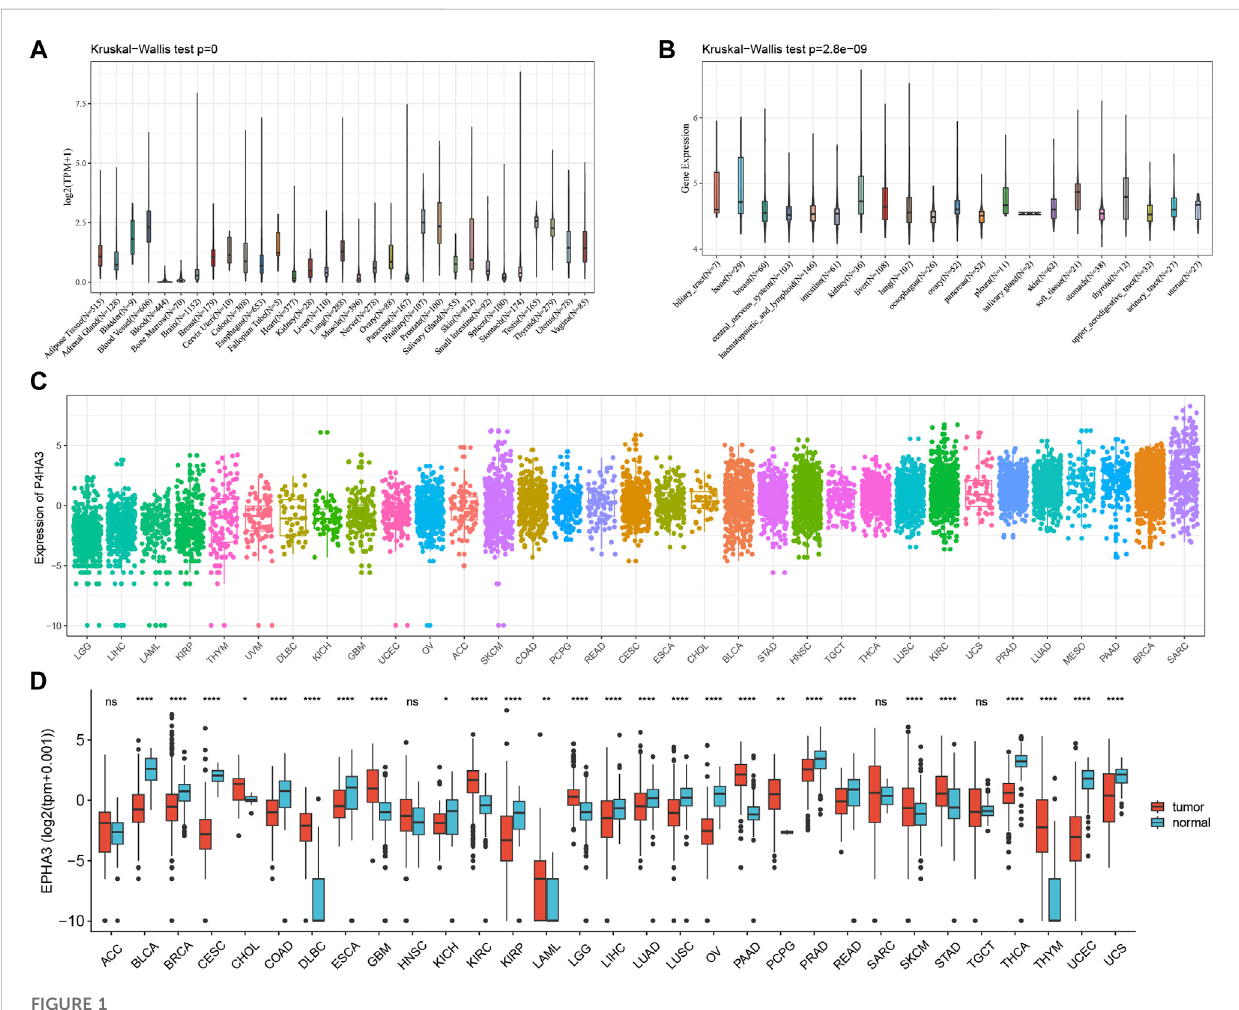
FIGURE 1 Expression of P4HA3 in normal and tumor tissues. (A) P4HA3 expression across 31 regular tissues and (B) 21 tumor cell lines. The mRNA expression landscapeof P4HA3 in (C) tumortissueonTCGAdatabaseand (D) normalandtumortissueonTCGAandGETxdatabase(* p < 0.05,** p < 0.01,and*** p < 0.001; ns: no signi fi cance). p values were based on the Wilcoxon rank sum